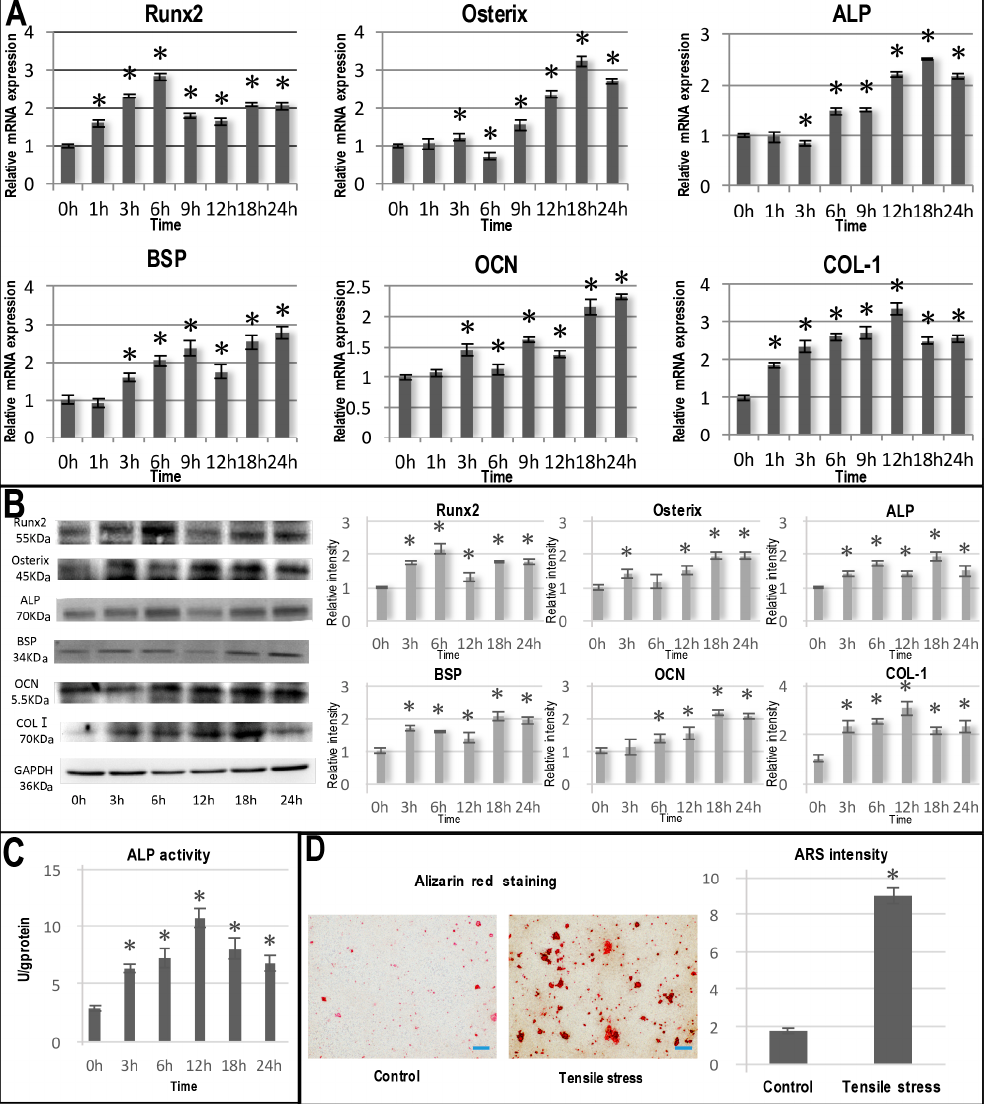
Figure 2. The cementoblastogenic differentiation of OCCM-30 cells under cyclic tensile stress stimulation. ( A ) Graphs depicting the relative mRNA expression of Runx2, Osterix, ALP, BSP, OCN and COL-I in OCCM 30 cells under tensile stress stimulation for 0, 1, 3, 6, 9, 12, 18 and 24 h; ( B ) Graphs depicting Western blot analyses for the protein expression of Runx2, Osterix, ALP, BSP, OCN and COL-I in OCCM 30 cells under tensile stress stimulation for 0, 3, 6, 12, 18 and 24 h; graphs depicting ALP activity ( C ) and Alizarin staining ( D ). Bar = 100 µm. * p < 0.05 in comparison with Time 0.